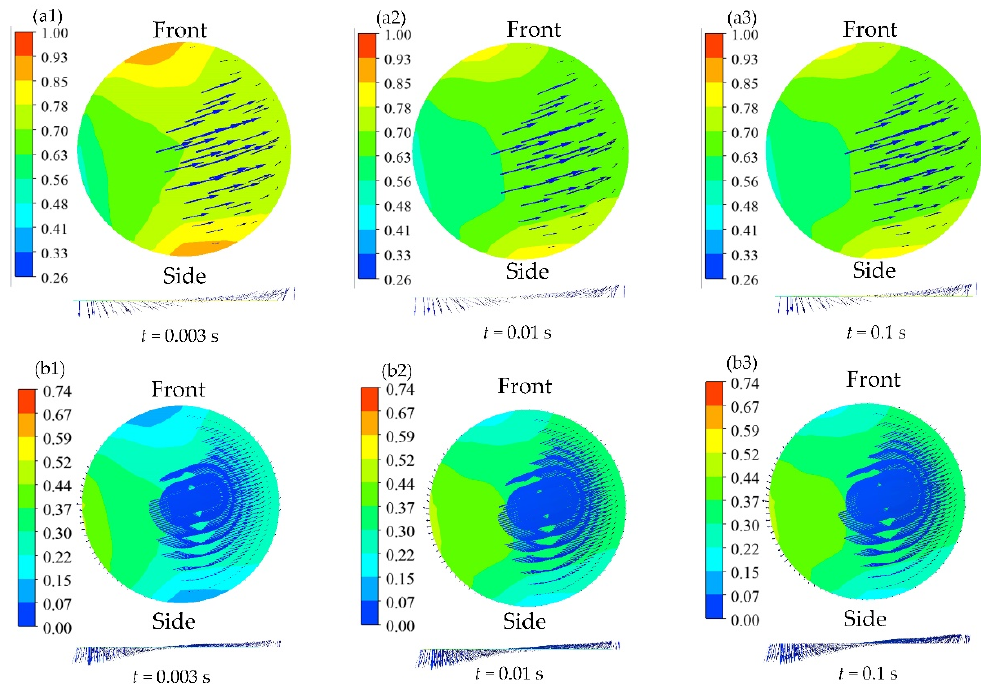
Figure 14. Velocity vector diagram of oil flow overlaid by the contours of oil volume fractions (( a1 ) is velocity vectors of oil when t = 0.003 s; ( a2 ) is velocity vectors of oil when t = 0.01 s; ( a3 ) is velocity vectors of oil when t = 0.1 s; ( b1 ) is velocity vectors of gas when t = 0.003 s; ( b2 ) is velocity vectors of gas when t = 0.01 s; ( b3 ) is velocity vectors of gas when t = 0.1 s).